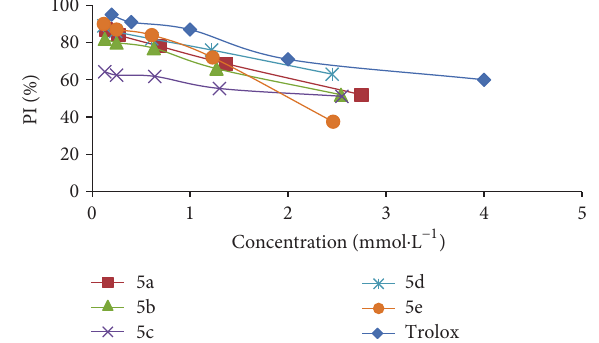
S 5: Scavenging ability on ABTS radical of compounds 5 .